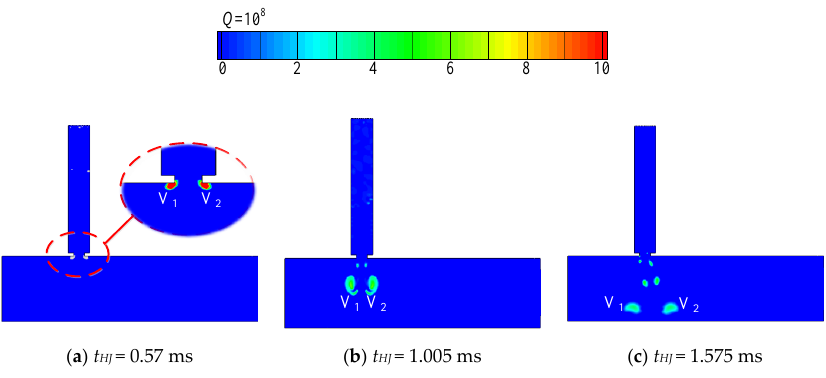
Figure 7. Variations of Q criterion field.